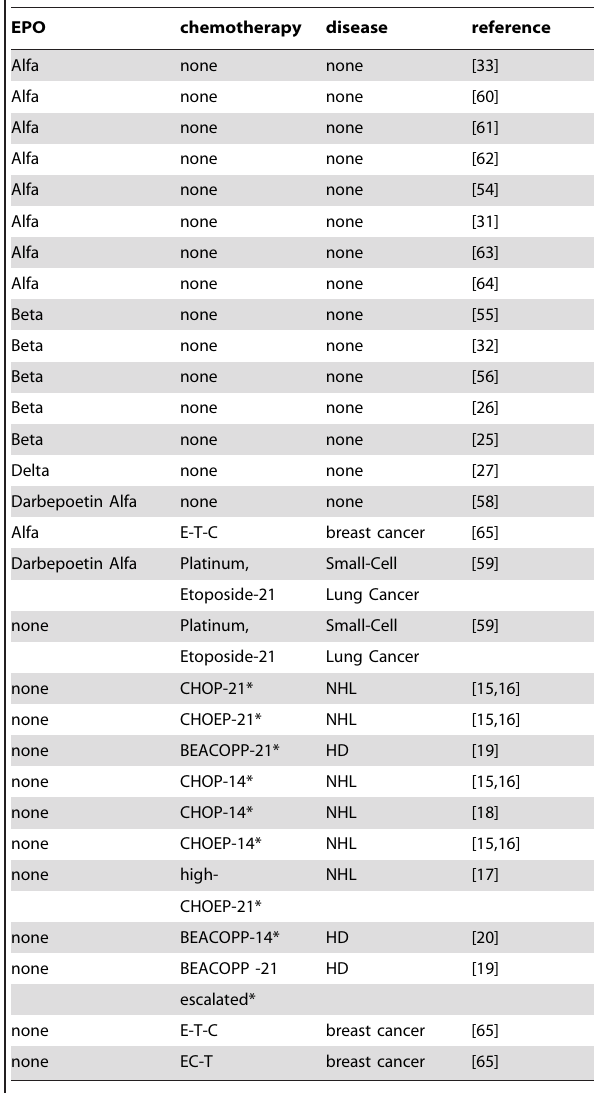
Table 1. Available data sets.